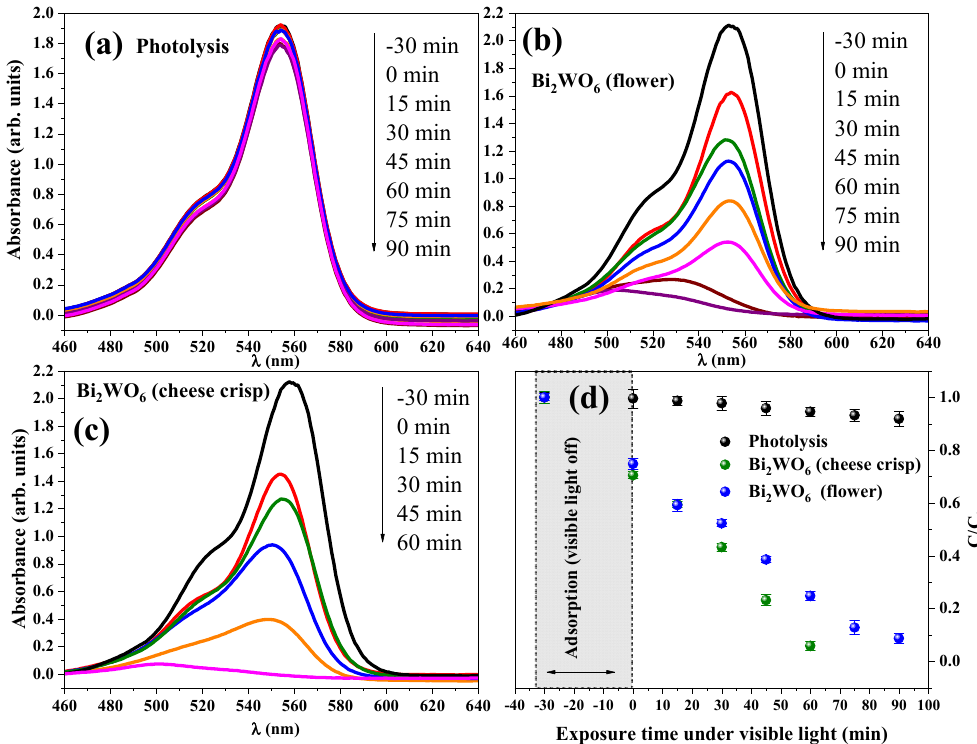
Figure 4. UV spectrum of RhB solution ( a ) photolysis, catalyzed by ( b ) Bi 2 WO 6 and ( c ) Bi 2 WO 6 -glyc microcrystals and ( d ) relative photodegradation C / C 0 against time (min).